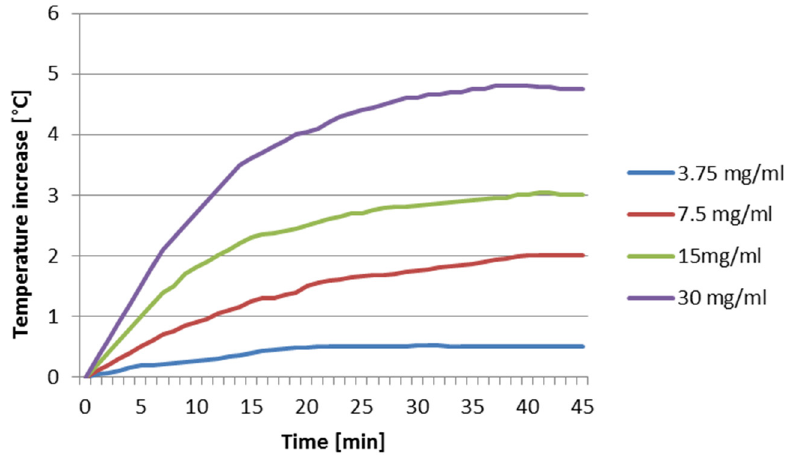
Figure 5. Plots of temperature change in time of samples 5–8 in frequency 168.5 kHz.